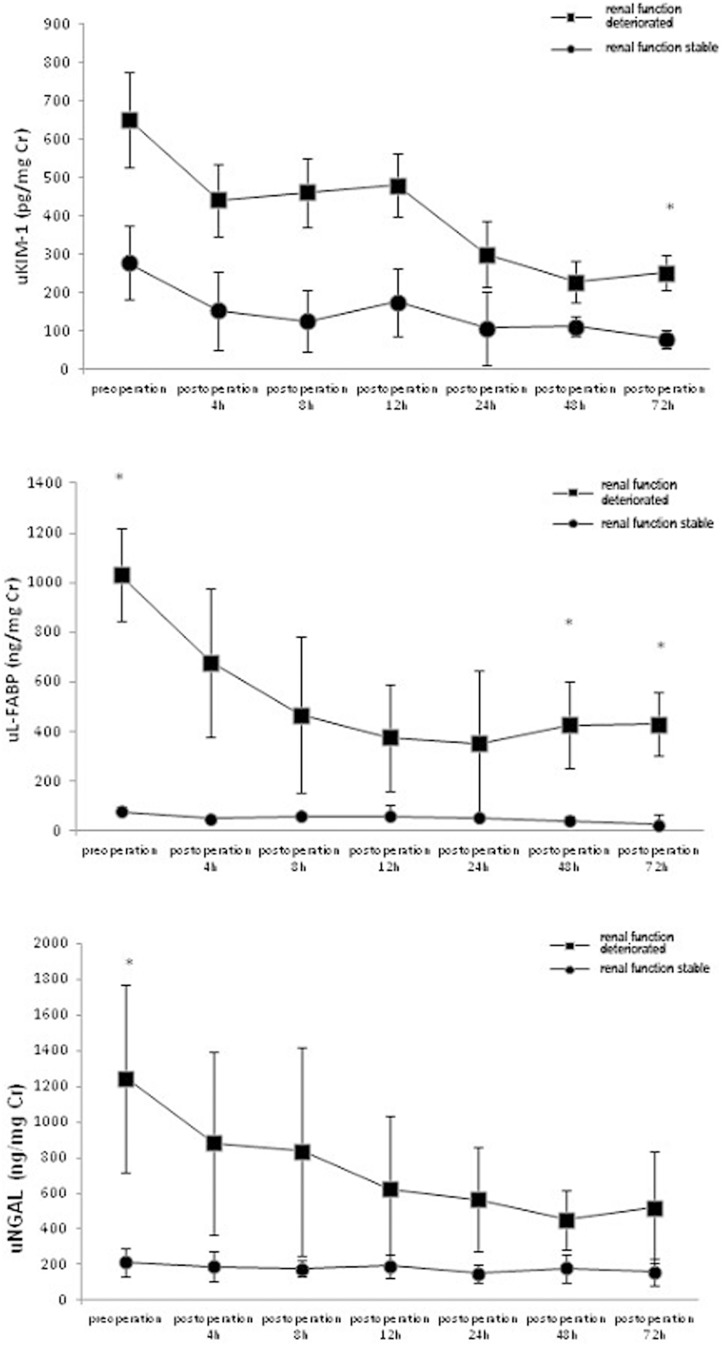
Comparison of the deteriorated renal function group and the stable group at 1-year follow-up.*The differences between the deteriorated renal function group and the stable group were statistically significant (P<0.05).